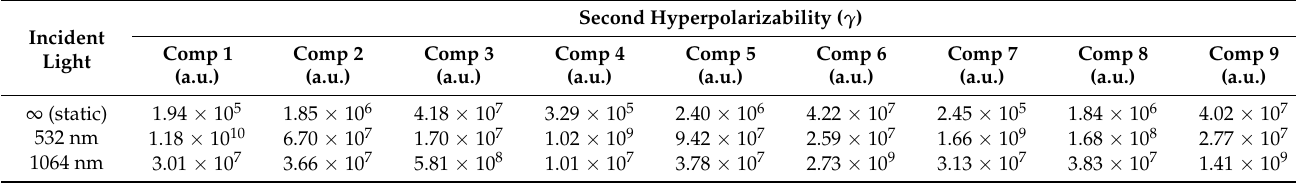
Table 2. Calculated static and dynamic second hyperpolarizability ( γ ).